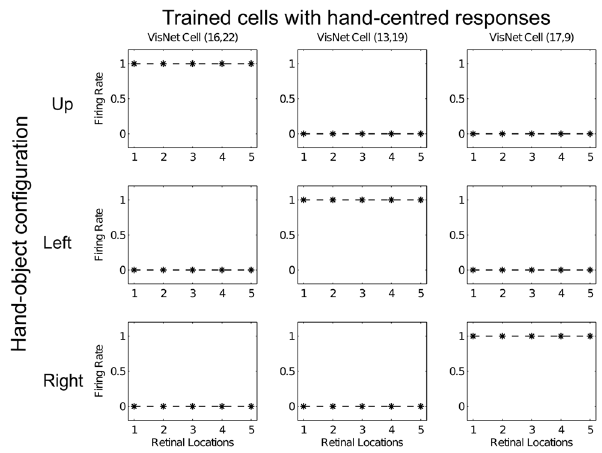
Figure 4. Response profiles of same three neurons in the top (fourth) layer of VisNet after training. Response profiles of the same three neurons from Fig. 3 after training on the images shown in Fig. 1. Conventions as in Fig. 3. It can be seen that each of the three cells responds selectively to just one of the hand-object configurations, and responds to that configuration over all five retinal positions shown along the abscissae. Moreover, each of the three hand-object configurations is represented by one of the